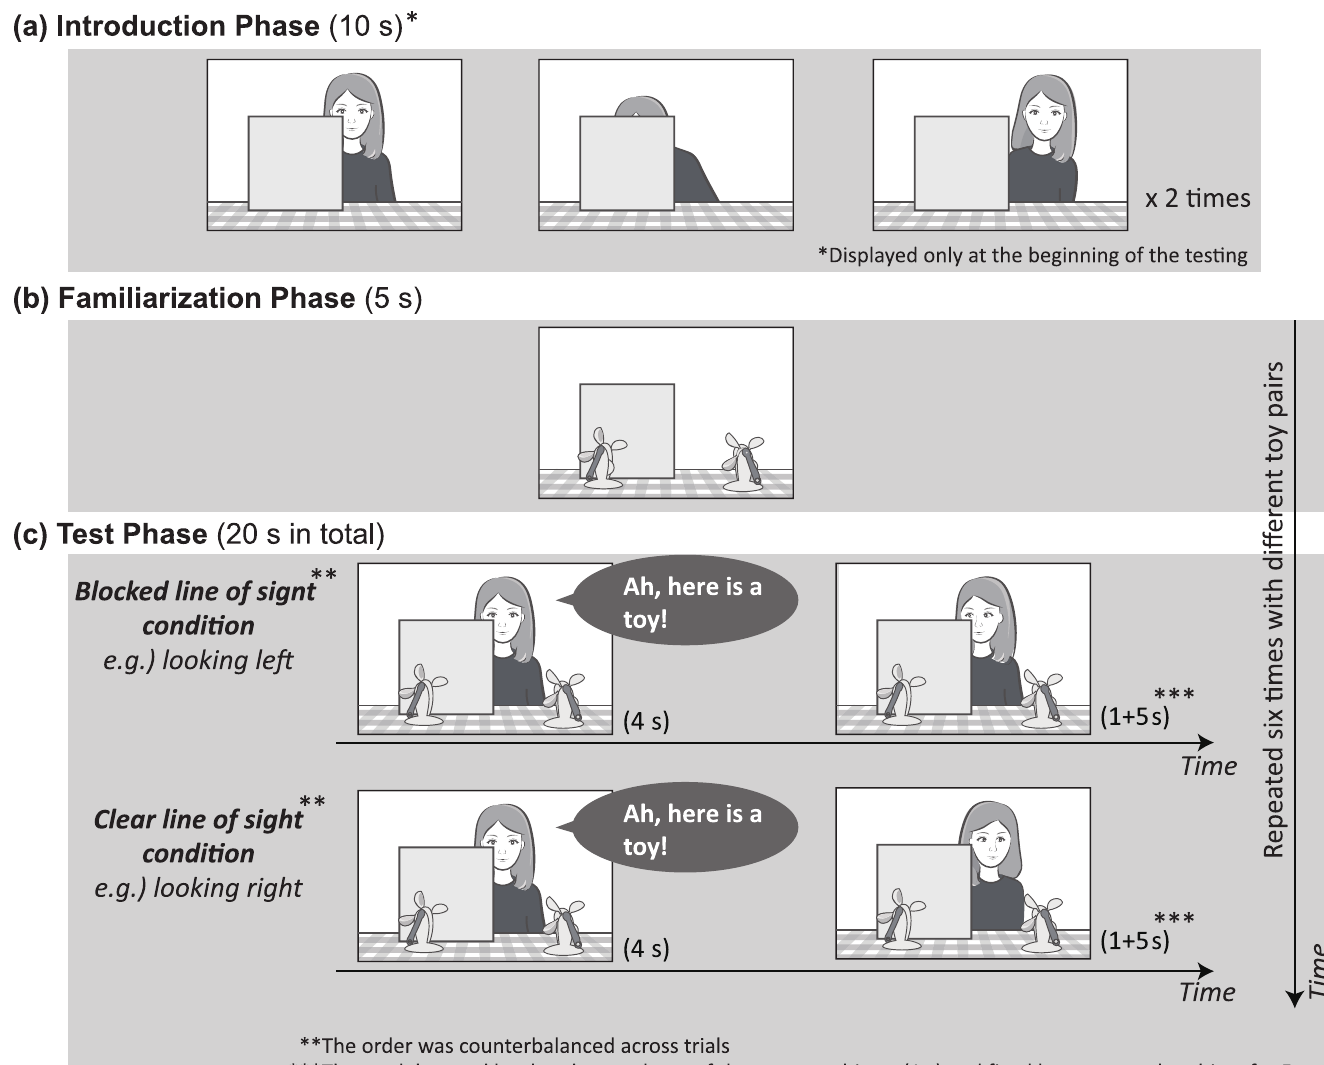
Fig 1. Schematic of study events. ( a ) Introduction Phase (10 s): The female model moved to the left and then to the right twice behind the barrier. This served to make infants aware that it occluded the model. ( b ) Familiarization Phase (5 s): Two identical toy objects were displayed with a barrier. One of the toy objects was placed in front of the barrier, and the other was not. ( c ) Test Phase (20 s in total): The model stared straight ahead for 4 s accompanied by a voice saying, “Ah, Omocha-ga Aruyo! (Ah, here is a toy!).” Then, the model gazed at either the toy object that was occluded by the barrier, (Blocked Line of Sight Condition) or the toy object that was not occluded by the barrier (Clear Line of Sight Condition). The order of the Blocked Line of Sight and Clear Line of Sight Conditions was counterbalanced. Note: An eye-catcher scene was displayed before the Introduction Phase and Familiarization Phase. It was also displayed before both the Blocked Line of Sight and Clear Line of Sight Conditions in the Test Phase, respectively. This was done to direct the infants’ visual attention toward the